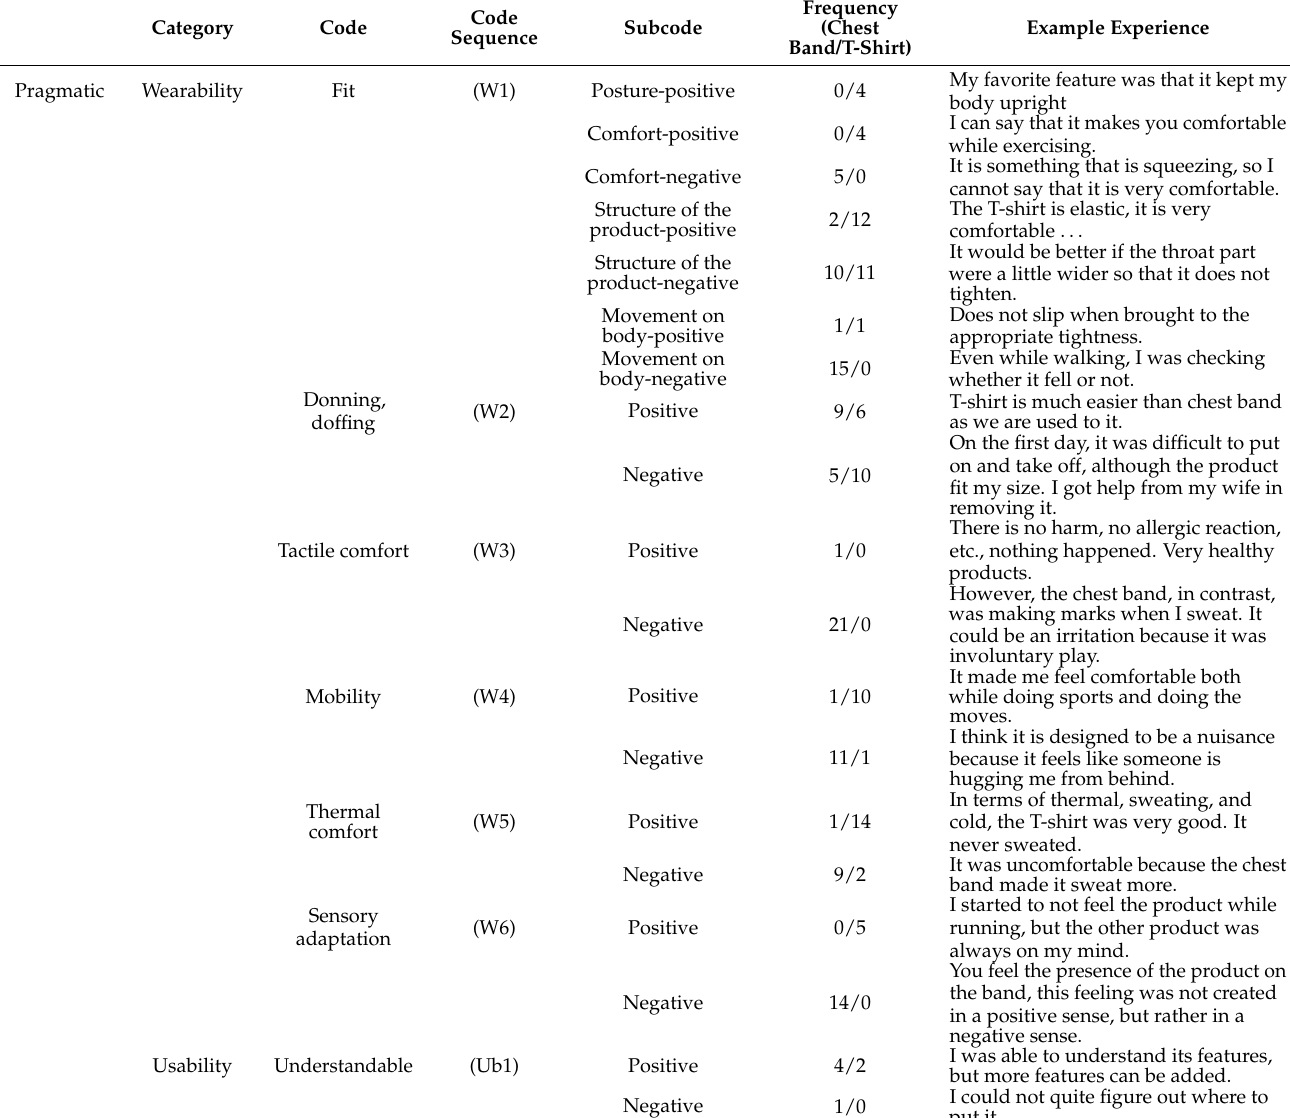
Table 2. Coding of user experience as positive and negative experiences in 6 categories in the pragmatic and hedonic framework. (The abbreviations of these codes are used in the